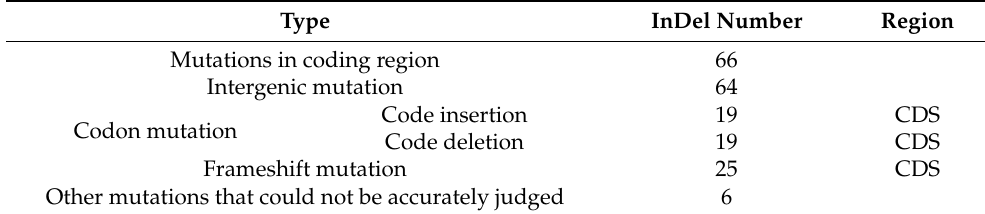
Table 7. InDel annotations of BmNPV